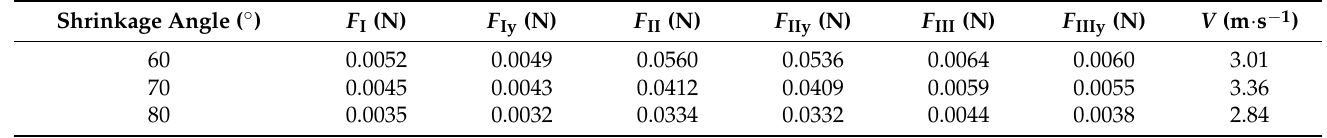
Figure 10. Influence of shrinkage angle on air pressure and velocity of conveying device. Note: I adsorption section; II deceleration section; III stable-acceleration section; IV constant-speed seeding section. Table 2. Mean ejection velocities and mean forces at each stage of seed